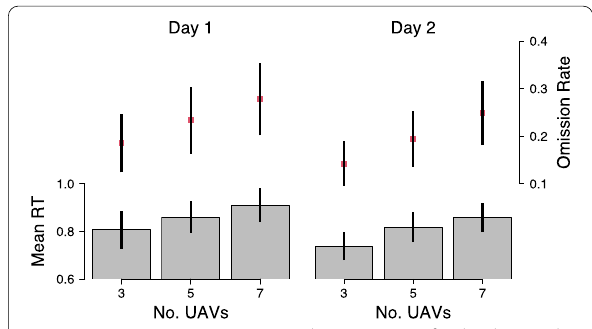
Fig. 3 Mean response time (RT) and omission rate for the three task difficulty levels, separately for the two testing days. Error bars show mean ± 1.96 SEM